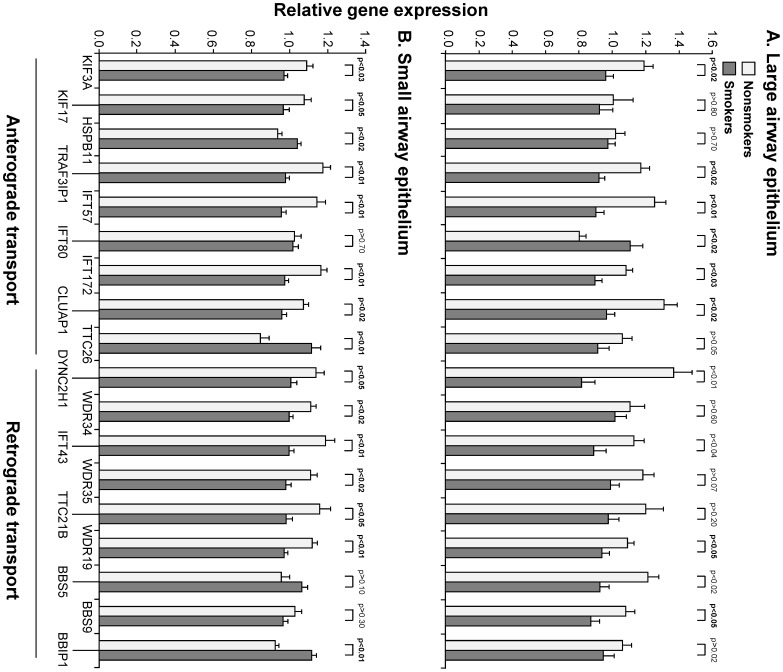
Expression of intraflagellar transport (IFT)-related genes significantly modified by smoking in the airway epithelium.Gene expression was assessed in nonsmokers and healthy smokers by microarray analysis in two independent data sets. The ordinate represents relative gene expression and specific genes are displayed on the abscissa. Nonsmokers are represented by light bars and healthy smokers by dark gray bars. Error bars represent standard error of the mean and p values are calculated using the Benjamini-Hochberg correction. Significant p values are displayed in bold font. Where multiple probe sets represent the same gene, the probe set with the lowest p value is displayed; where p values are identical, the probe set with highest fold-change is displayed. A. Expression in the large airway epithelium (nonsmokers n = 21 and healthy smokers n = 31). B. Expression in the small airway epithelium (nonsmokers n = 28 and healthy smokers n = 69).